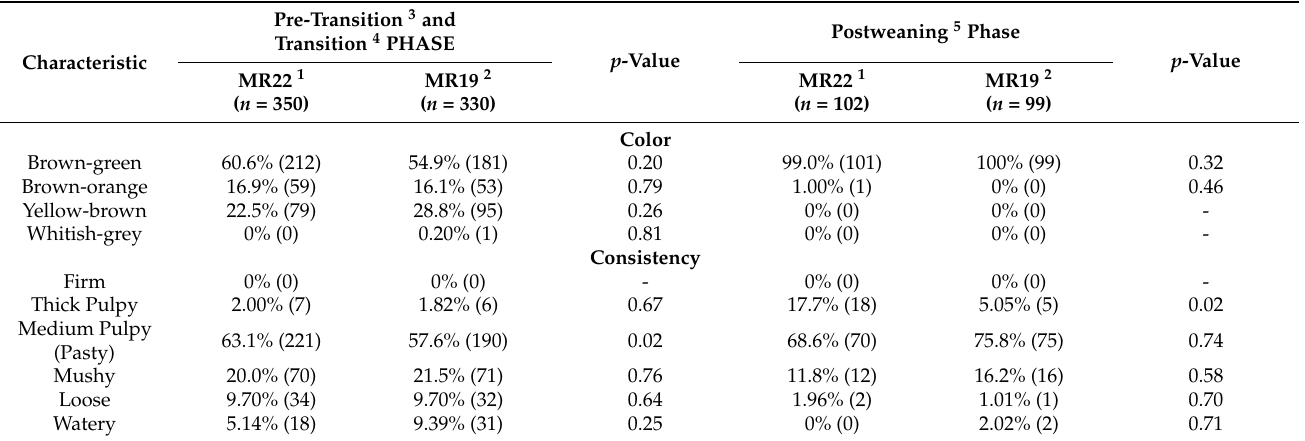
Table 5. Characteristics of fecal samplings during the pre-transition and transition phase as well as the postweaning phase depending on crude protein content of milk replacer (MR) given in percent and number of observations ( n